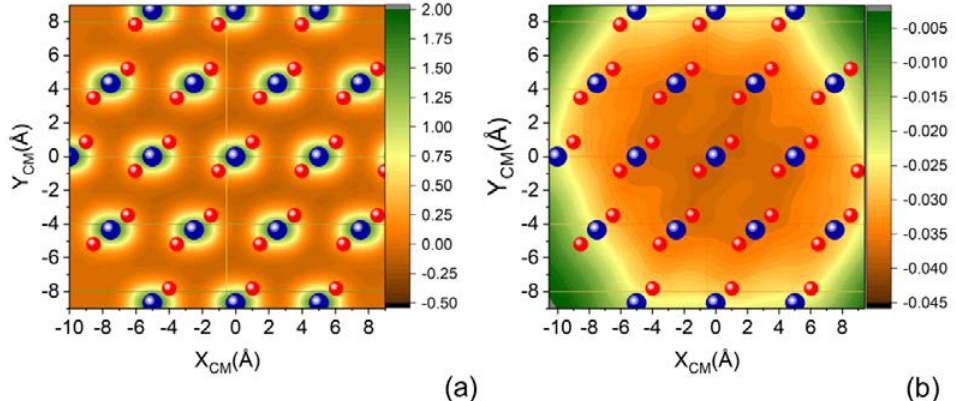
Figure 3. ( a ) XY projection of complete PES for N 2 molecule impinging with molecular axis parallel to the XY plane of quartz surface for ( a ) Z CM = 2.0 Å and ( b ) Z CM = 3.5 Å.